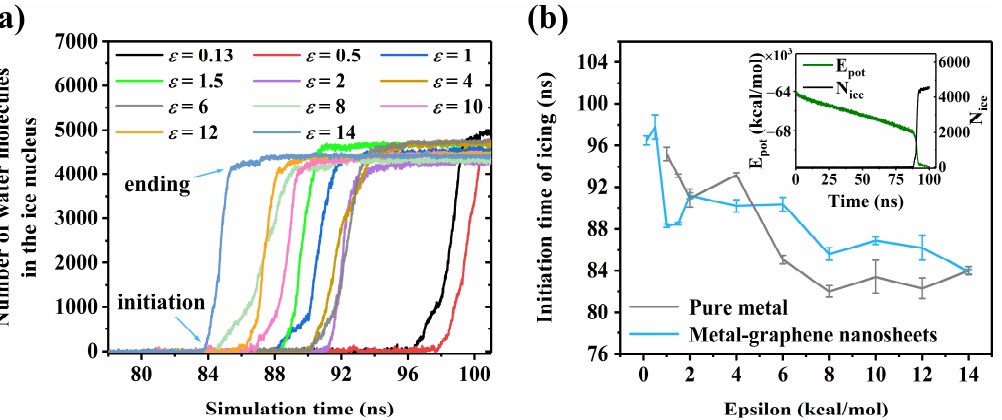
Figure 2. Freezing of liquid water in different surface conditions. ( a ) Number of water molecules in the ice cluster on metal–graphene nanosheet surfaces with different surface hydrophilicities. The interaction strength between the metal and water molecule ε w-m varied from 0.13 to 14.0 kcal/mol. ( b ) Initiation time of icing with different surface hydrophilicities of a metal substrate. Inset shows total potential energy E pot of the system and the number of water molecules in the ice nucleus, N ice , during the whole simulation time. The data refer to the metal–graphene nanosheet system, and ε w-m was fixed to 1.0 kcal/mol in the inset of ( b ).